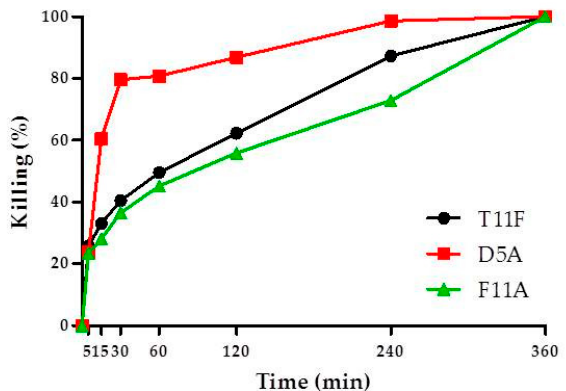
Figure 5. Time kinetics of in vitro activity of selected peptides against Candida albicans SC5314 cells. The activity is expressed as percentage killing, reported data represent mean values from three independent experiments (variability ≤ 10%). Each experiment was performed in triplicate. As determined by two-way ANOVA with Bonferroni post hoc test, significant differences were observed at 15, 30, 60, 120, and 240 min for D5A vs. T11F and F11A ( p < 0.001 at all times, with the exception of D5A vs. T11F, p < 0.05 at 240 min), while a significant difference between T11F and F11A was observed only at 240 min ( p < 0.01).